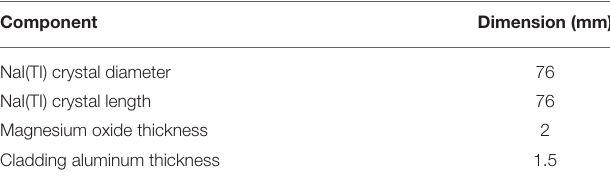
TABLE 1 | Technical dimensions of detector provided by the